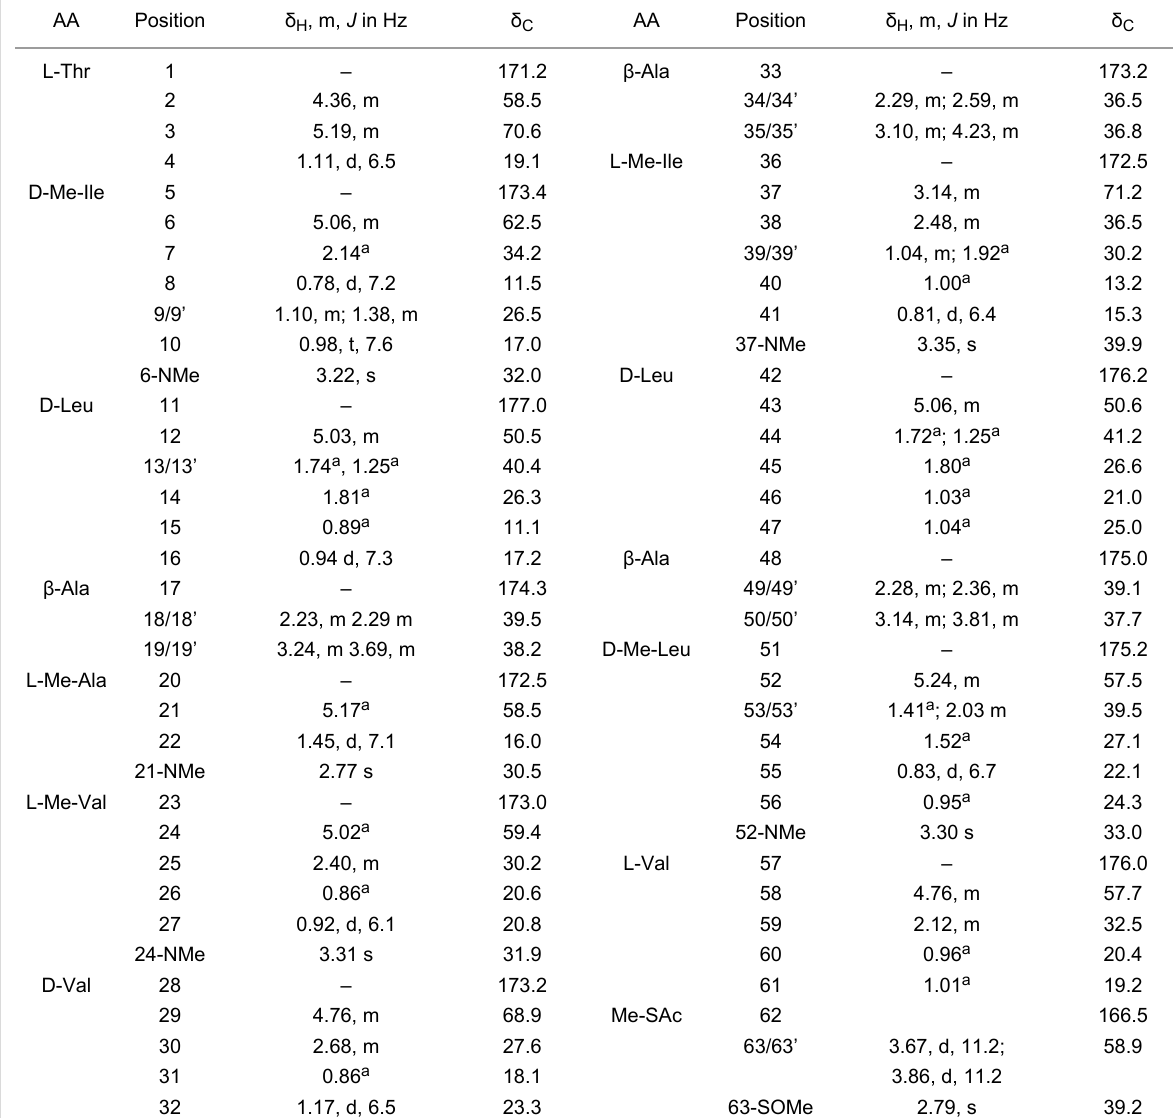
Table 1: 1 H (500 MHz) and 13 C (125 MHz) NMR data of sulfinyltheonellapeptolide in CD 3 OD ( 2 ).